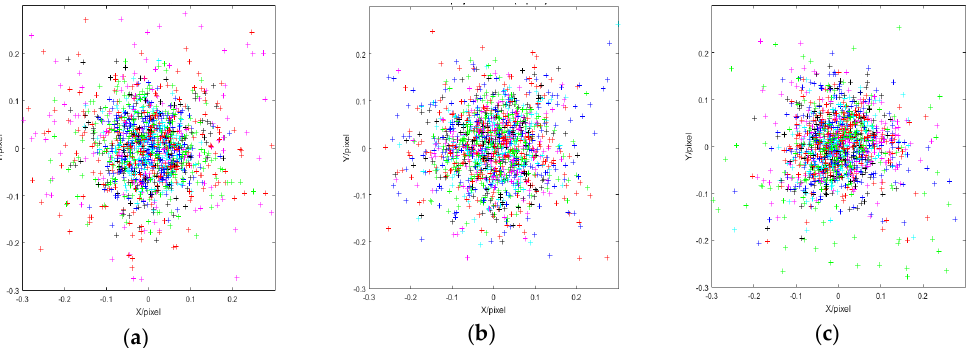
Figure 5. Distribution of the reprojection errors. ( a ), ( b ), and ( c ) are the reprojection errors of camera_up, camera_mid and camera_down, respectively.